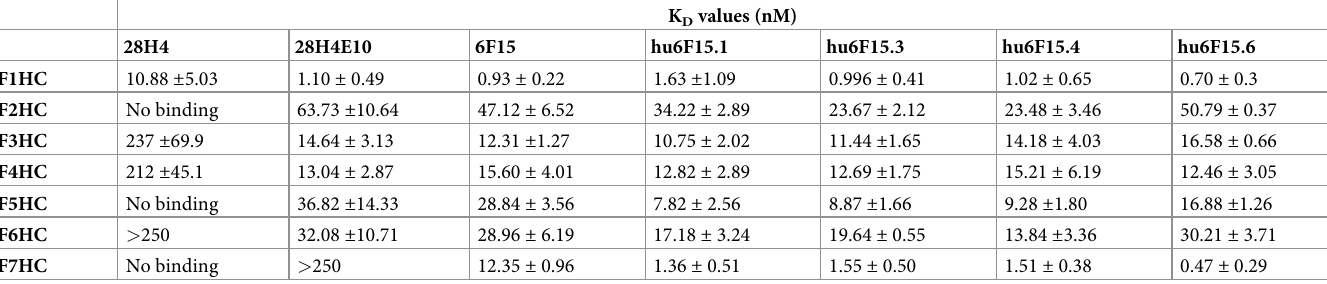
Table 1. K D values of yeast displayed scFv mAbs as measured by using flow